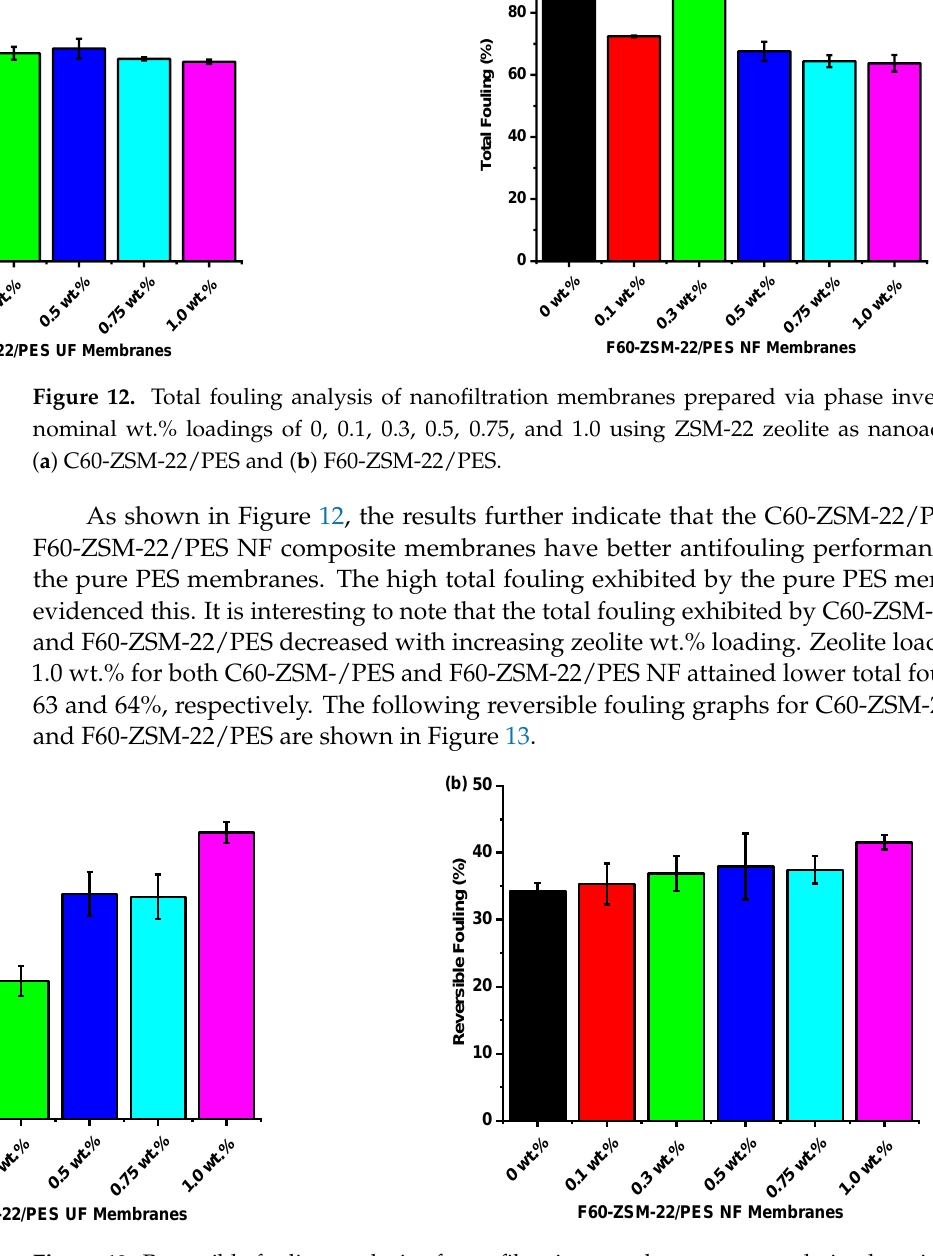
Figure 13. Reversible fouling analysis of nanofiltration membranes prepared via phase inversion to nominal wt.% loadings of 0, 0.1, 0.3, 0.5, 0.75, and 1.0 using ZSM-22 zeolite as nanoadditives: ( a ) C60-ZSM-22/PES and ( b ) F60-ZSM-22/PES. As usual, the pure PES membranes exhibit lower reversible fouling. However, the resulting NF membranes as well exhibit lower reversibility as the zeolite wt.% loading is increased. Reversible BSA protein molecule adsorption causes reversible fouling that can be removed by hydraulic cleaning through membrane backwashing. The obtained NF membranes exhibit higher reversibility at lower zeolite wt.% loadings, which is an indication that the obtained membrane can be reused upon backwashing. Figure 14 shows the irreversible fouling graphs for both C60-ZSM-22/PES and F60-ZSM-22/PES NF